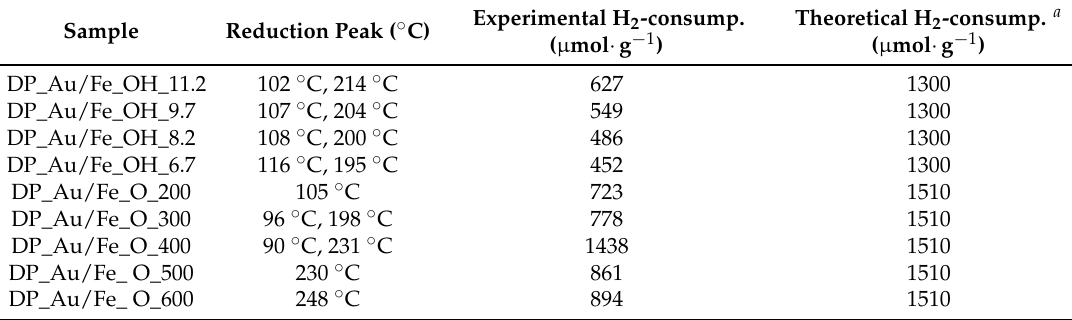
Table 2. Hydrogen consumption (H 2 -consump.) of gold